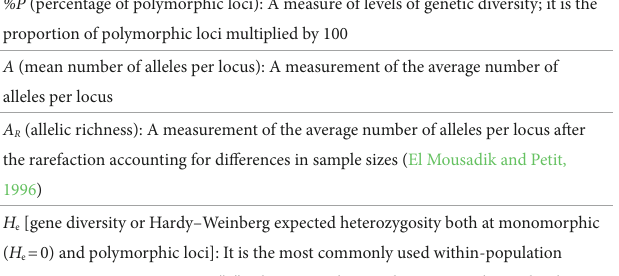
TABLE 1 Definition of population genetic terms for seed plants cited in the